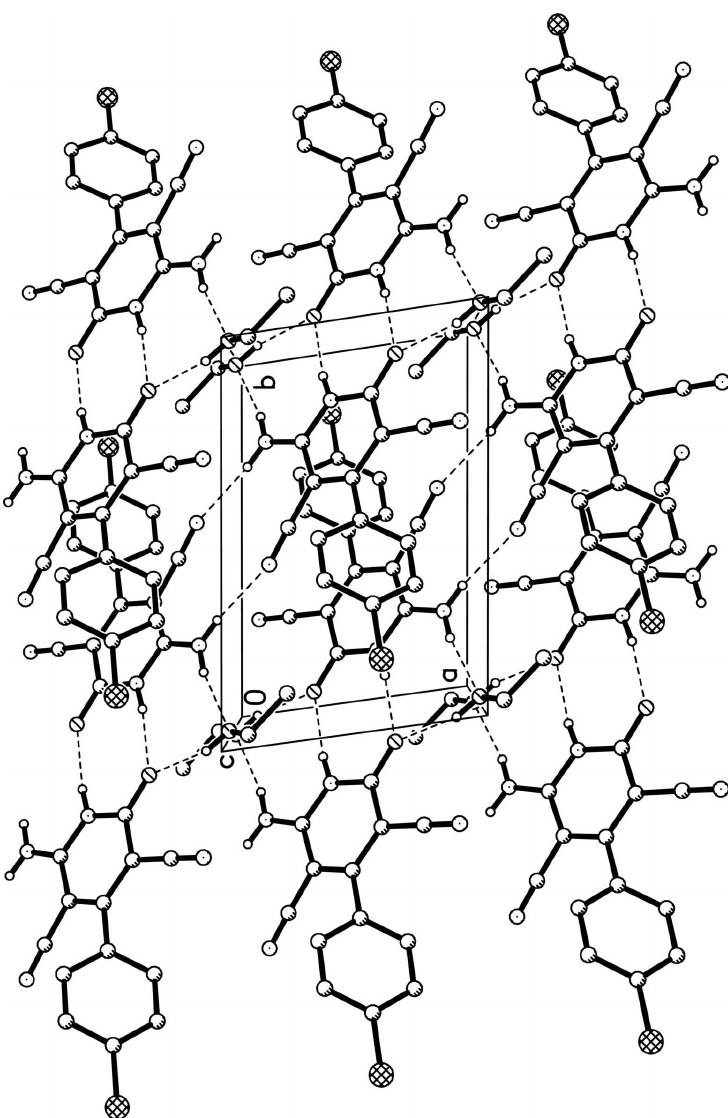
The packing diagram of title compound viewed along the a